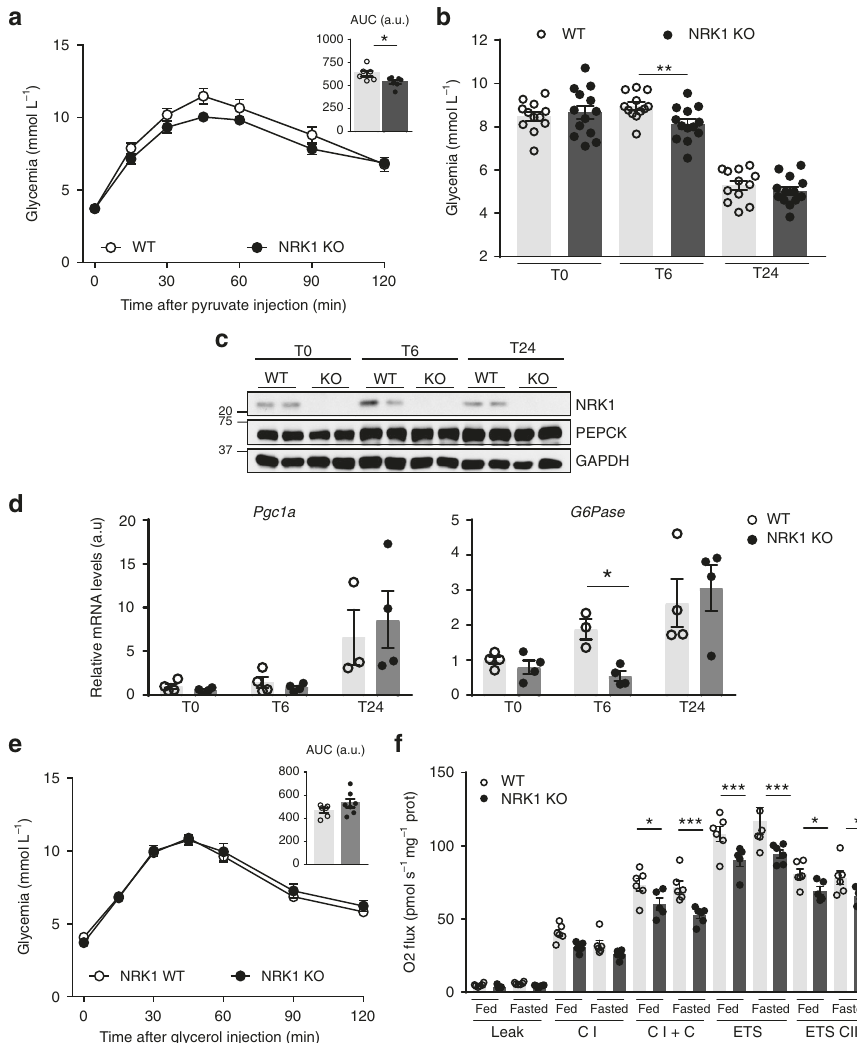
Fig. 1 NRK1 KO mice display lower gluconeogenic capacity. a Blood glucose levels during intraperitoneal pyruvate tolerance tests in NRK1 KO ( n = 7) and control (WT) ( n = 6) mice. b Blood glucose levels in NRK1 KO ( n = 13) and WT ( n = 12) mice subjected to a fasting time course. c Livers were snap frozen at the indicated time-points during a fasting time course. A piece of liver was then homogenized for protein extraction. Then, 20 μ g of protein were used to evaluate NRK1, PEPCK, and GAPDH protein levels through western blot. d Livers were snap frozen at the indicated time points during fasting time course. Then, RNA was extracted to evaluate mRNA levels of genes involved in gluconeogenesis ( n = 4 mice per group). e Blood glucose level during intraperitoneal glycerol tolerance test ( n = 6 for WT mice, n = 7 for NRK1 KO mice). f Mitochondrial respiratory capacity properties were evaluated in liver homogenates from NRK1 KO and WT mice in fed and 24h-fasted conditions ( n = 6 for WT mice; n = 5 for NRK1 KO mice). Results shown are mean ± SEM; * and *** indicate statistical difference between genotypes at p < 0.05 and p < 0.001, respectively. The individual values and statistical tests used for